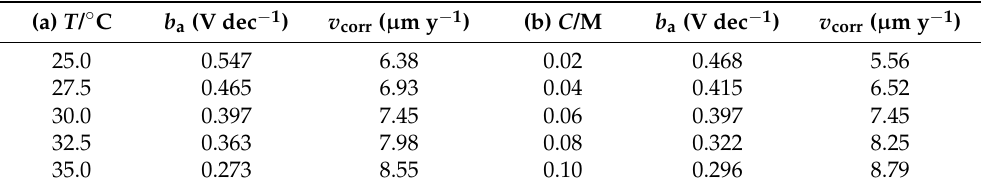
Figure 4. Tafel curves on Hf in the ethanol and acetonitrile ( V / V = 1:1) solution. ( a ) Containing 0.06 M Et 4 NCl at a scanning rate of 1 mV/s and different temperatures. ( b ) Containing different concentrations of Et 4 NCl at a scanning rate of 1 mV/s and 30 °C. Table 1. Reaction kinetic parameters of Hf anodic corrosion/dissolution in the Et 4 NCl-based anhy- drous ethanol system extracted from the Tafel curves. The kinetic parameters were calculated based on the Butler–Volmer equation. Condition: on Hf in the ethanol and acetonitrile ( V / V = 1:1) solution. (a) Containing 0.06 M Et 4 NCl at a scanning rate of 1 mV/s and different temperatures. (b) Containing different concentrations of Et 4 NCl at a scanning rate of 1 mV/s and 30 °C.